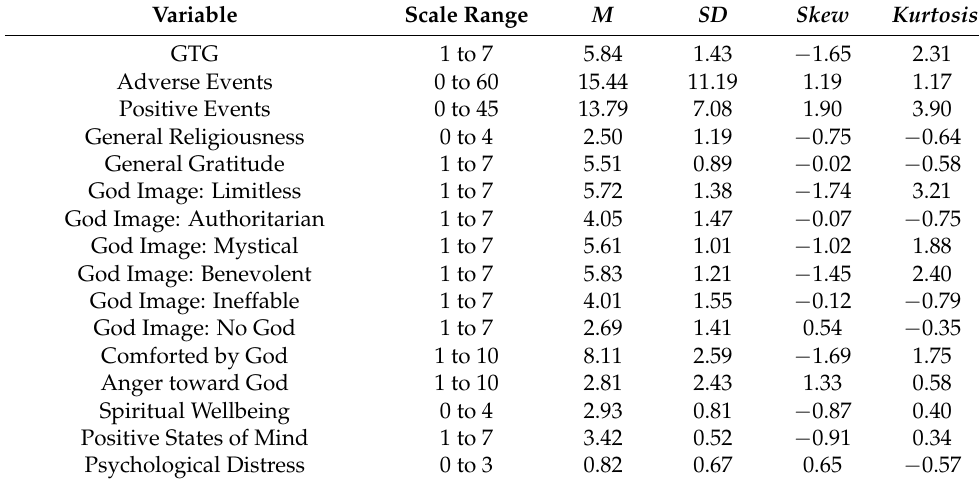
Table 1. Descriptive Statistics for